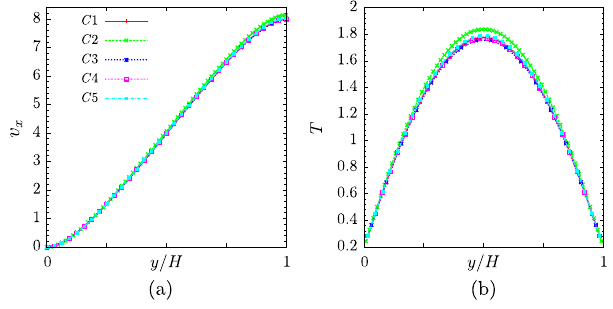
FIG. 8. The comparisons of the (a) velocity and (b) temperature profiles under the various calculation conditions for the applied shear stress σ 0 ¼ 0 . 08 .